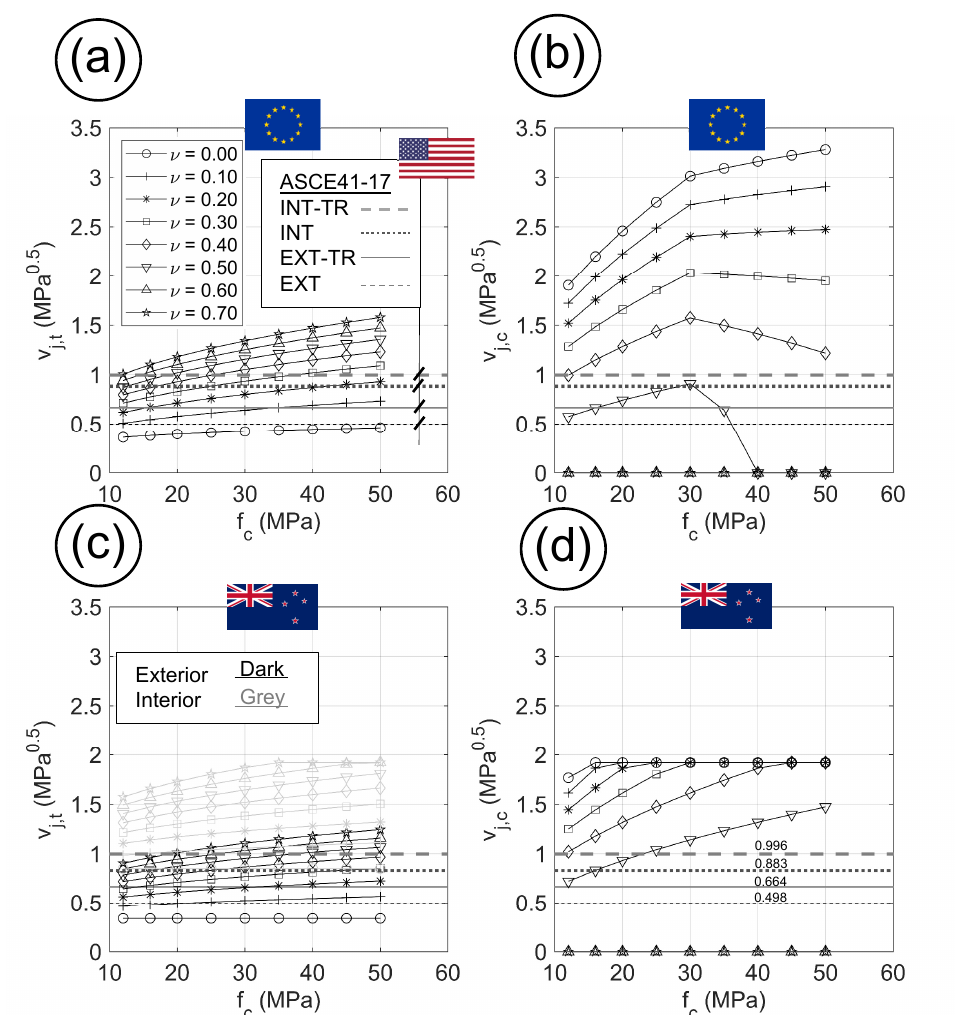
Figure 6. Results for parametrical analysis on beam–column joint strength (normalized shear strength v j []MPa 0.5 ]) predicted by different building codes: ( a ) Equation (6); ( b ) Equation (7); ( c ) Equation (8); ( d ) Equation (9). All the plots includes the constant values of the prediction given by ASCE41-17